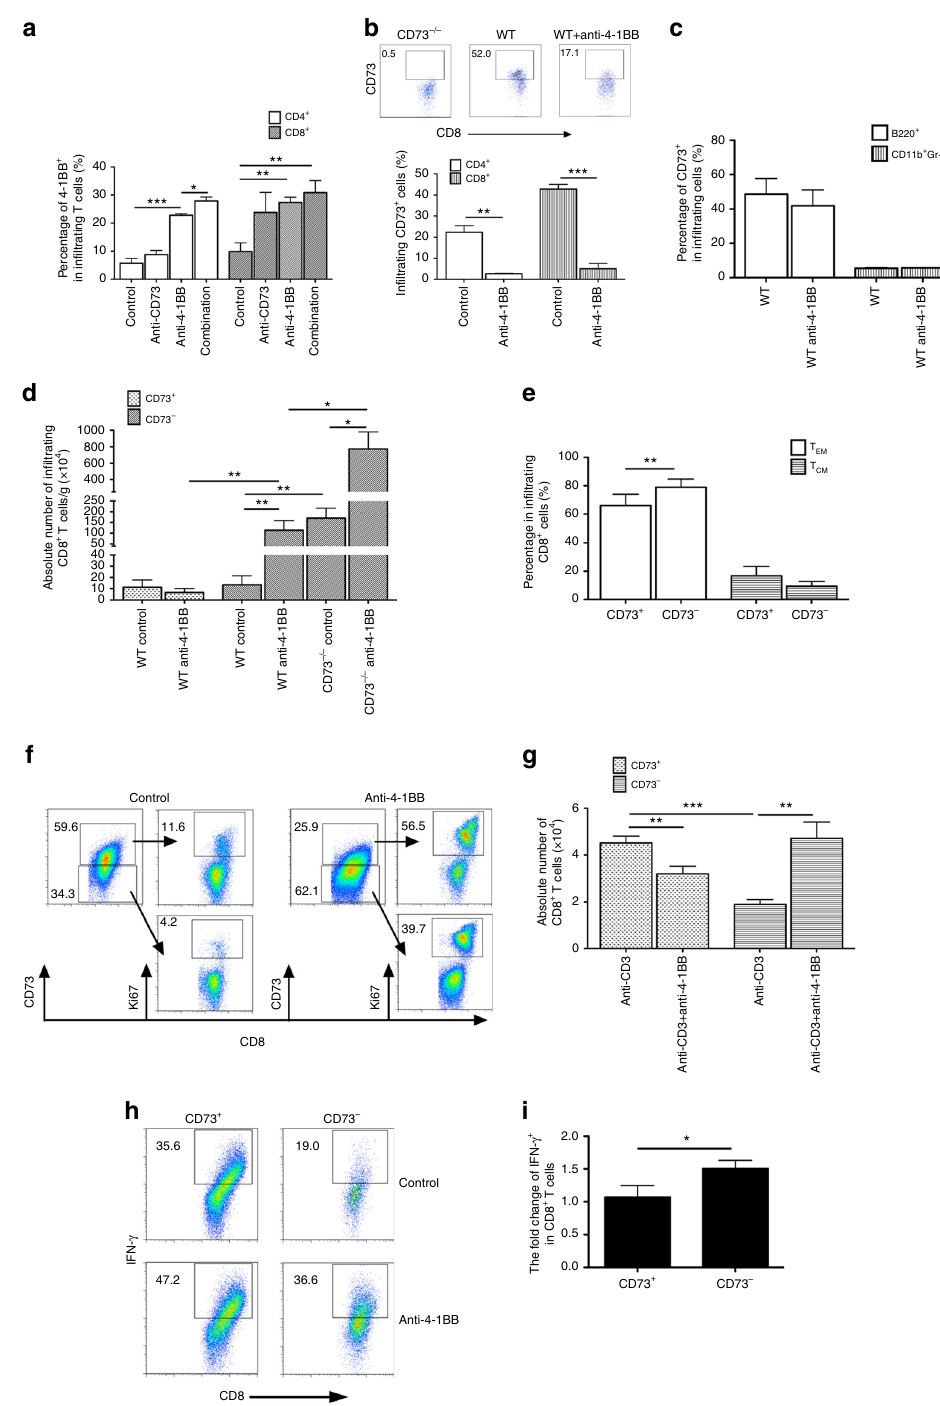
Fig. 3 Anti-4-1BB preferentially drives the expansion of CD73-negative CD8 + T cell subset. Percentage of 4-1BB + cells ( a ), or CD73 + cells ( b ) among in fi ltrating CD4 + and CD8 + T cells in B16-SIY tumor-bearing mice treated as indicated was determined by fl ow cytometry (5 mice per group). c Percentage of CD73 + cells among tumor-in fi ltrating B220 + cells or Gr1 + CD11b + MDSCs in B16-SIY-bearing mice treated as indicated. d The absolute number of CD73 + versus CD73 − subsets from tumor-in fi ltrating CD8 + T cells were calculated in B16-SIY-bearing mice treated with control IgG or anti-4-1BB. e Percentage of T EM (CD62L - CD44 + ), or T CM (CD62L + CD44 + ) in CD73 + versus CD73 - subsets from B16-SIY-in fi ltrating CD8 + T cells treated with anti- 4-1BB. Puri fi ed CD8 + T cells from naïve mice were treated with control IgG or anti-4-1BB in the presence of anti-CD3/anti-CD28 in vitro. The expression levels of CD73 or Ki67 in CD8 + T cells were evaluated by fl ow cytometry. f The representative dot plots are depicted. g The absolute number of CD73 + versus CD73 - subsets from cultured CD8 + T cells was also counted. h The representative dot plots showed the percentage of IFN- γ + cells in CD73 + versus CD73 - subsets from CD8 + T cells. i The fold changes of IFN- γ + cells in CD73 + versus CD73 - subsets were calculated. * p < 0.05, ** p < 0.01, *** p < 0.001. Unpaired and paired Student ’ s two-tailed t test were used. Data (mean ± SEM) are representative of 2 independent experiments with 5 independently analyzed